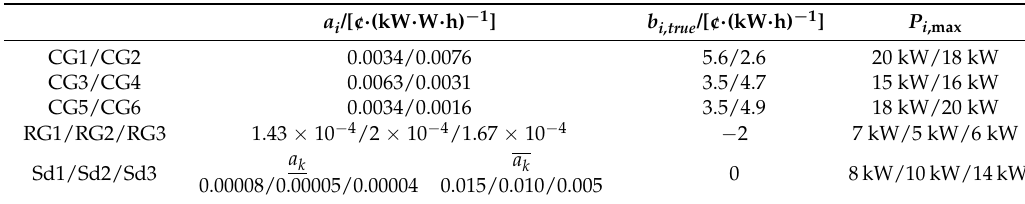
Figure 3. Schematic of the MGC under study, incorporating three sub-microgrids. Table 1. Simulation parameters.